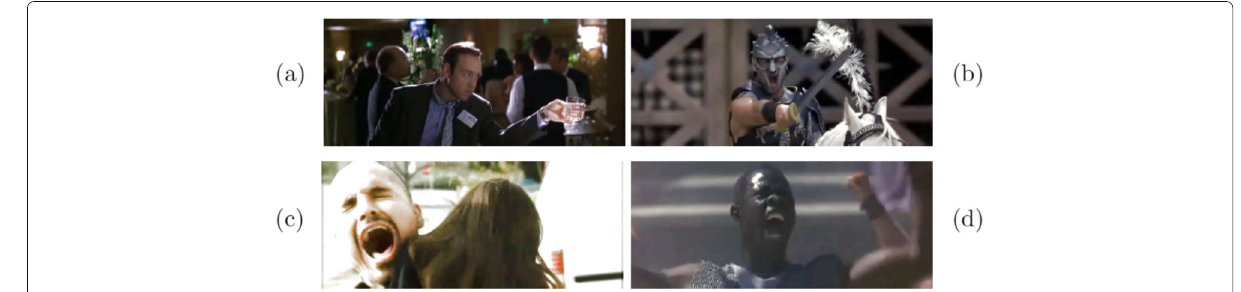
Fig. 8 Sample frames for a low arousal, b high arousal, c very negative valence, and d very positive